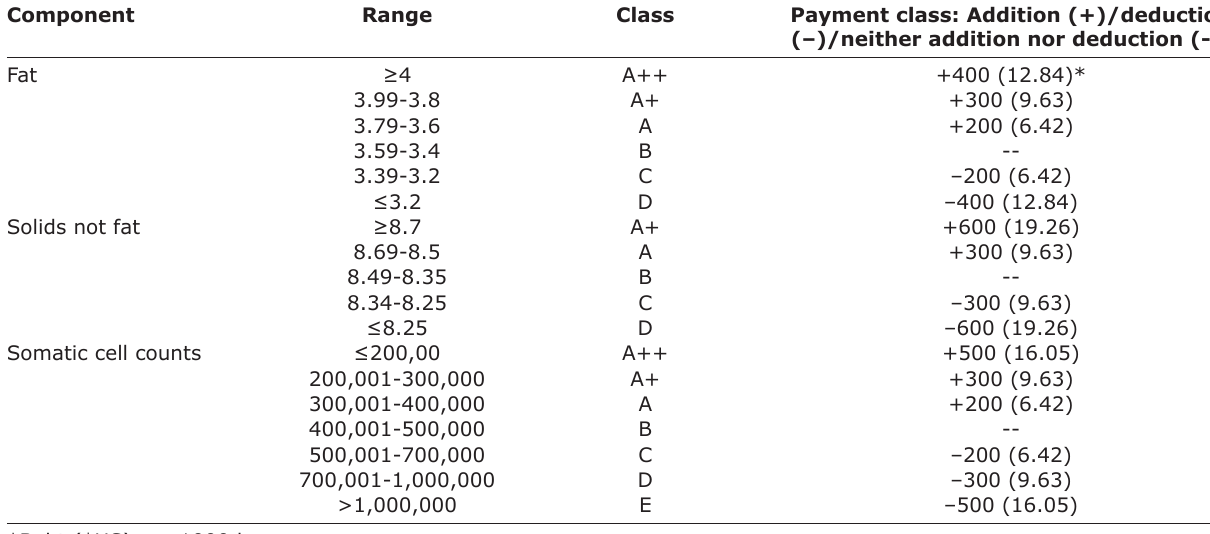
Table-1: Payment class is made by addition, deduction, or neither through the payment program based on milk quality of bone marrow transplant in Thailand.